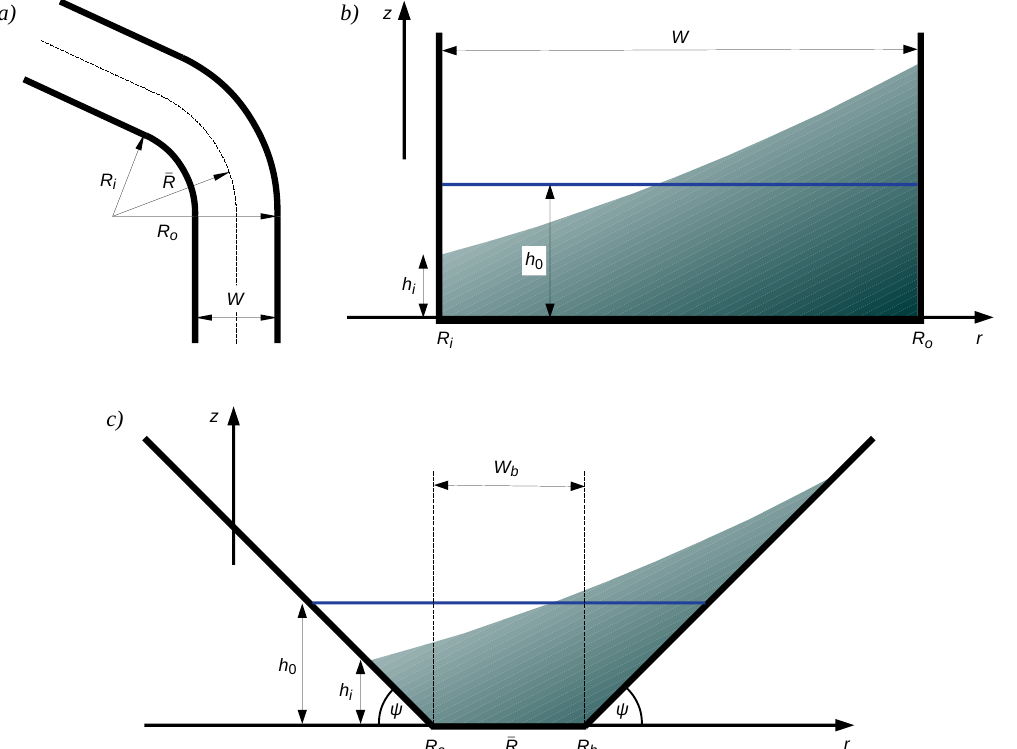
Figure A1. Simple channel geometries used in the text: ( a ) Normal view and ( b ) cross section of a rectangular channel of constant width with a circular bend. ( c ) Prismatic channel. Note that the bank slope angle ψ is measured in the cross-sectional plane, which in general is inclined relative to the horizontal. The flow depth h 0 in a straight segment is drawn such that the cross-sectional area is somewhat smaller than in the superelevated state to indicate that the mean flow velocity in the bend may be lower than in the straight segments due to increased